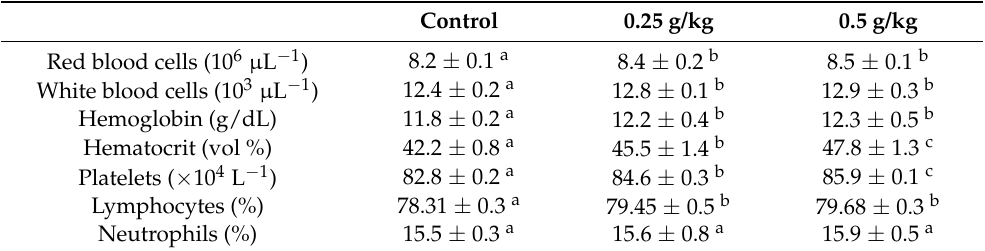
Table 9. Hematological parameters of male rats after 90 days of treatment with O. basilicum .